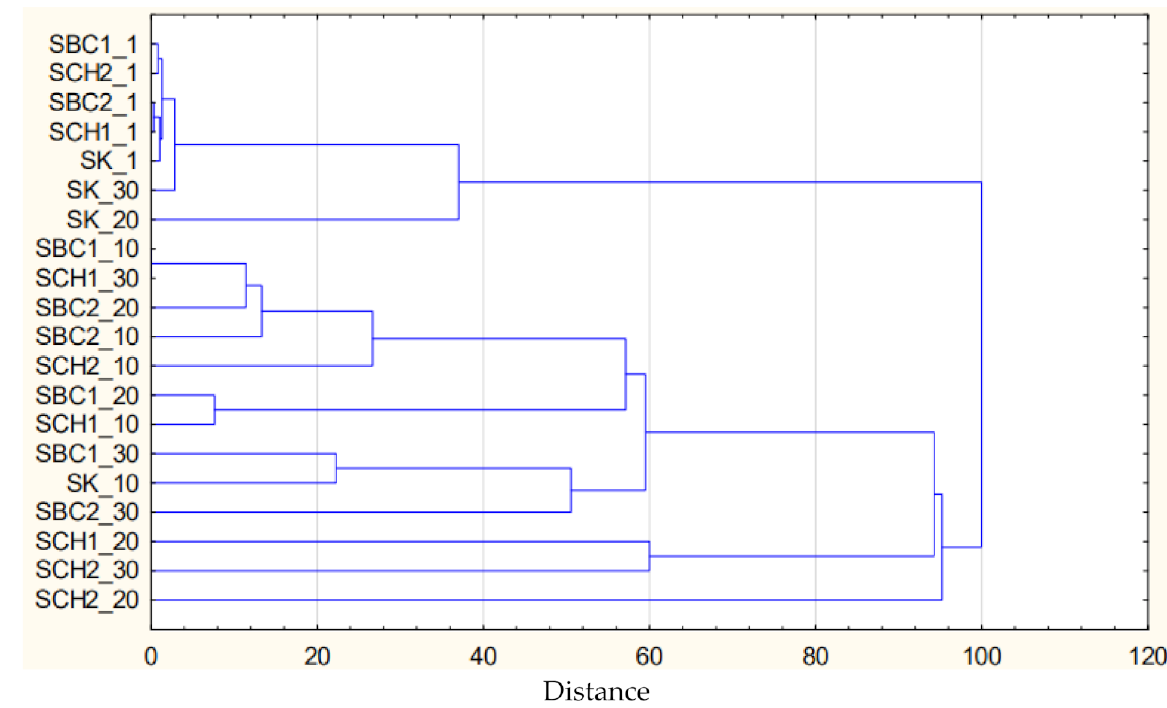
Figure 3. Cluster analysis dendogram. SK—control sample; SCH1—sample with 1% addition of chia seed; SCH2—sample with 2% addition of chia seed; SBC1—sample with 1% addition of black cumin seed; SBC2—sample with 2% addition of black cumin